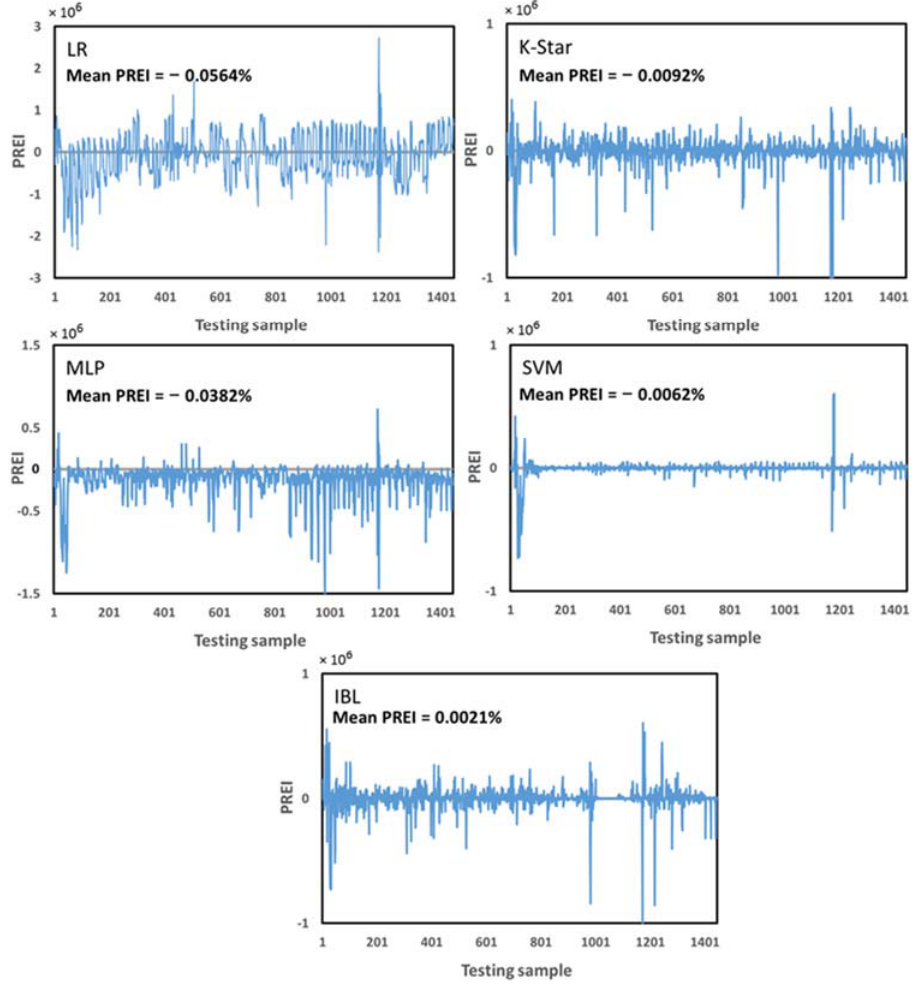
Figure 5. Error graph of the estimated cost compared to the actual cost reported in the project bids.